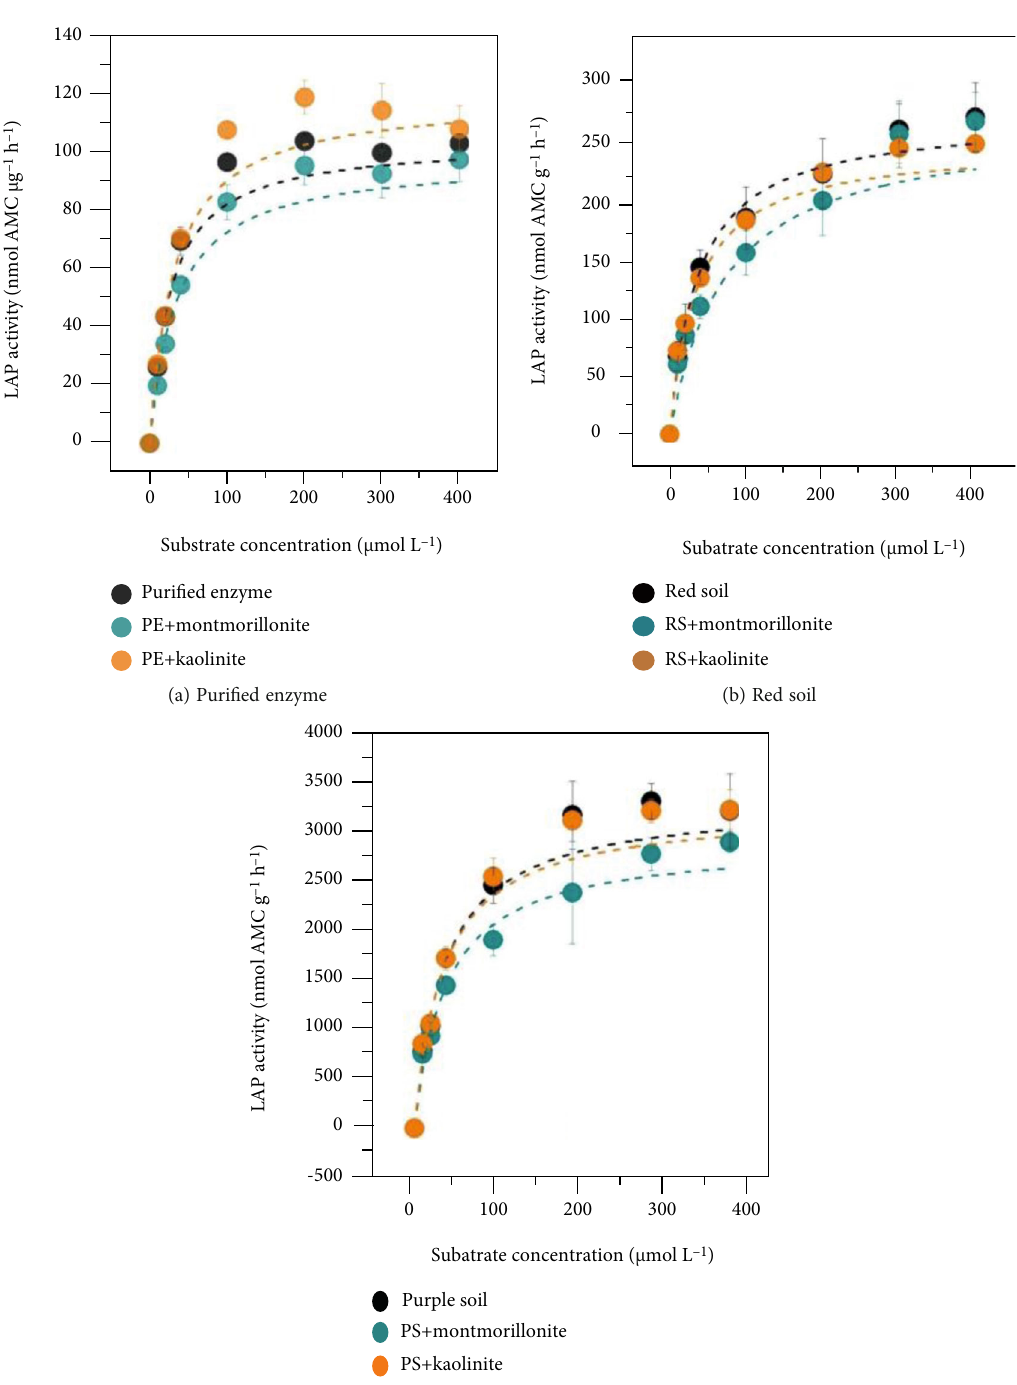
Figure 5: E ff ect of adding di ff erent amounts of montmorillonite and kaolinite on the kinetic curve of LAP in puri fi ed LAP, LAP in red soil, and LAP in purple